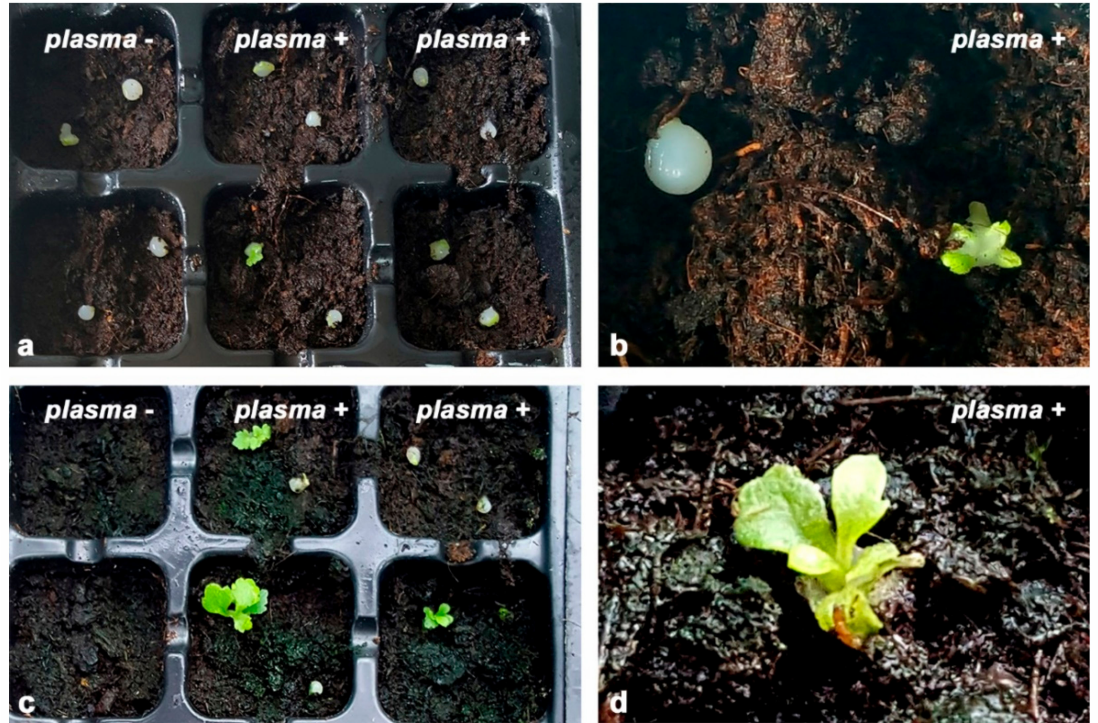
Figure 2. Chrysanthemum synseed germination under ex vitro conditions, cv. Pr é cocita